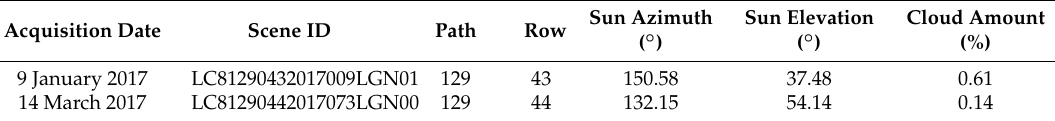
Table 1. Landsat-8 Operational Land Imager (OLI) images used in this